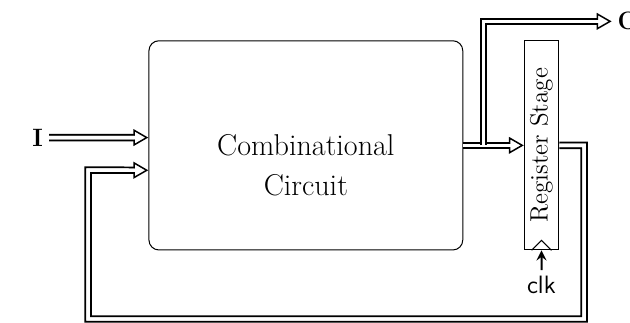
Figure 1: General schematic of a sequential